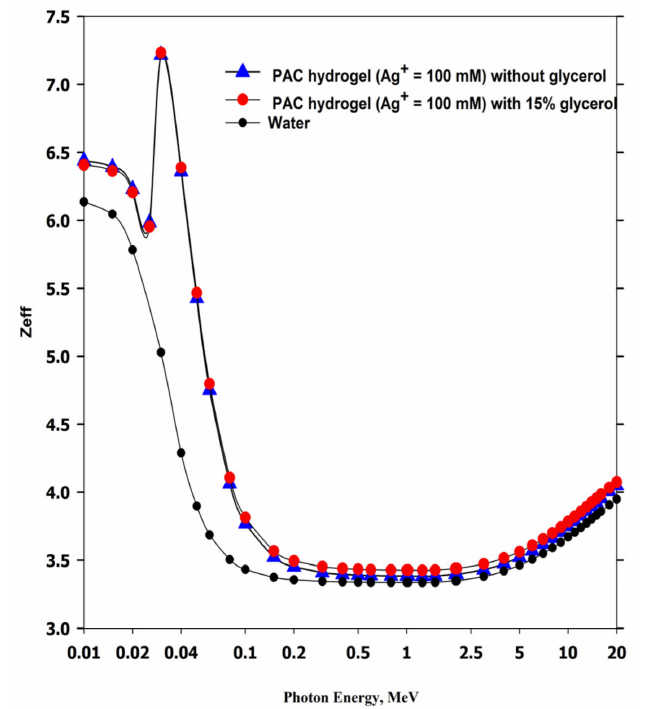
Figure 10. Effective atomic number (Z eff ) of PAC hydrogel dosimeter (100 mM Ag + ) without and with glycerol and compared with water as a reference